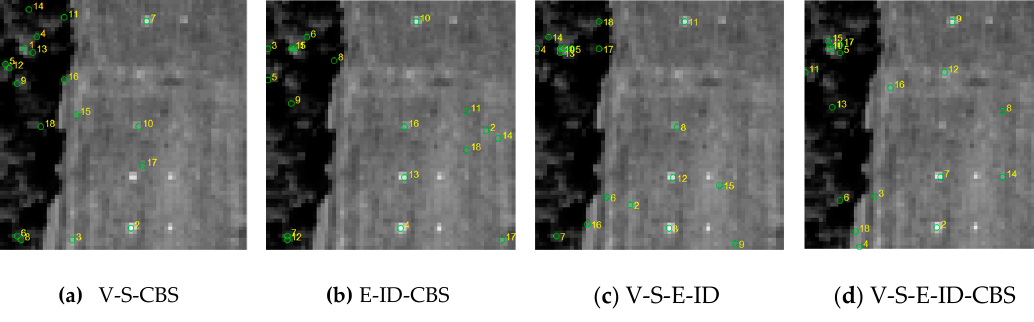
Figure 6. The 18 pixels found by ATGP using PBSF and the selected bands in Table 3.